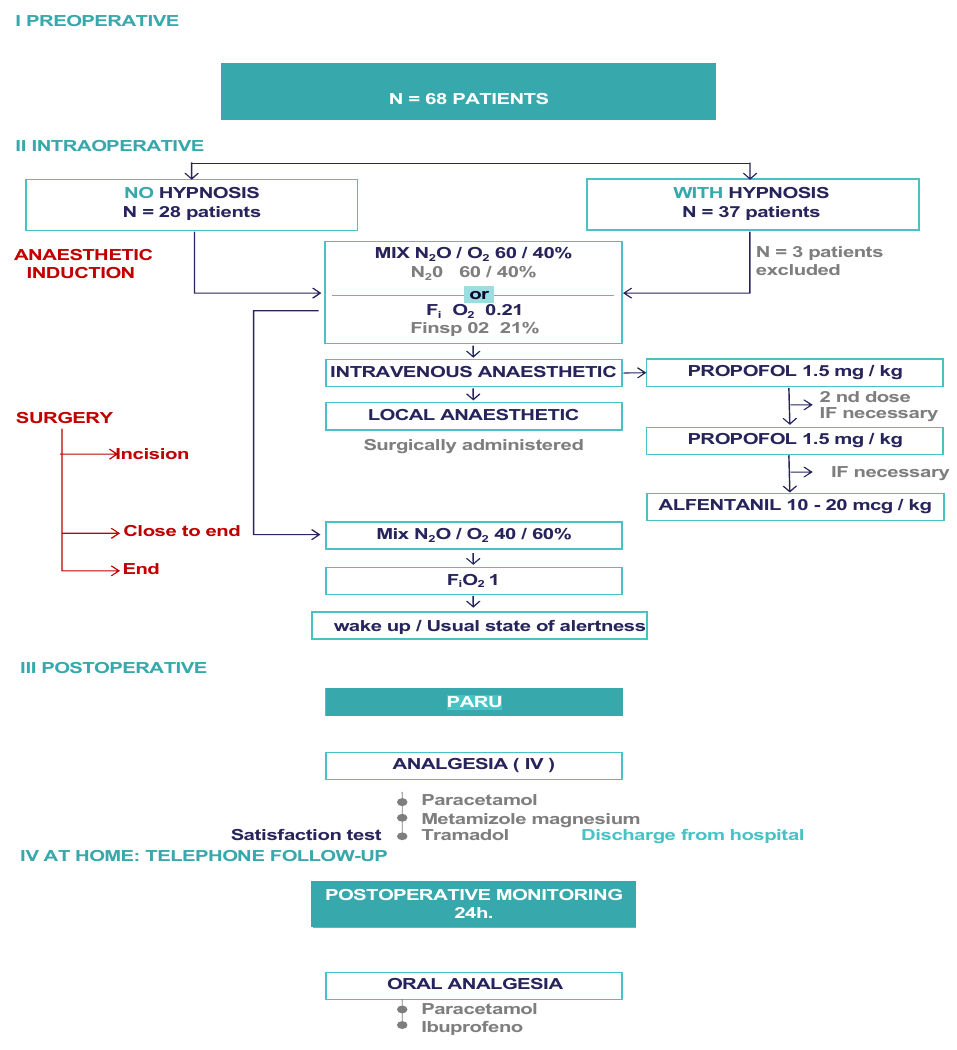
Figure 2. Study procedure and interventions compared: Hypnosis and attention distraction. I Preoperative: recruitment of patients: II Intraoperative: depending on the day with hypnosis (intervention), the day with no hypnosis (attention distraction techniques), ap- plication in both arms of induction and maintenance anaesthesia by means of intravenous and/or inhalation agents or local anaesthetic and elimination; awakening (no hypno- sis)/return to normal alertness (hypnosis) III. PACU control of vital signs and pain. IV Postoperative monitoring 24 h: pain control.